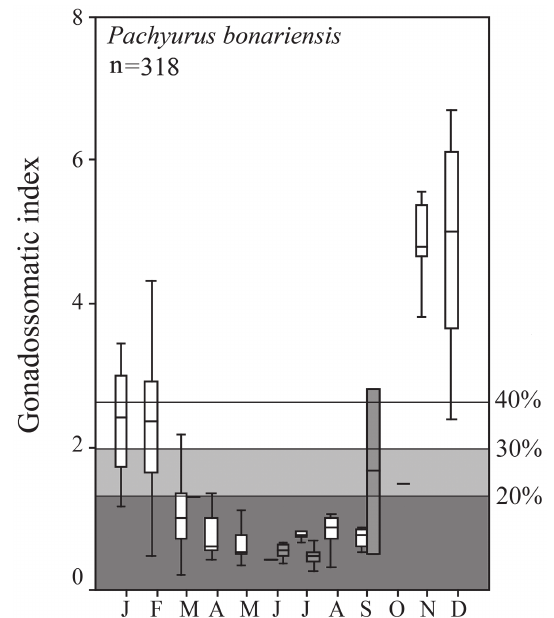
Fig. 11. Monthly variation of Pachyurus bonariensis GSI values (adult females only) in Guaíba Lake (white) and Casamento Lake (dark gray), Rio Grande do Sul, Brazil (median, 25-75% quartiles and lower-upper GSI limits by month and site). Three GSI cut-off values were tested with respect to the maximum GSI recorded for each species, for delimitation of reproductive months: 20% (G and 40% (G 40